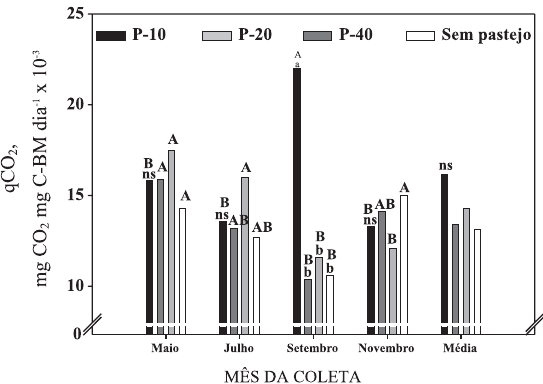
Figura 4. Quociente metabólico ( q CO ) no ciclo de 2 pastejo, na camada de 0 a 10 cm, de um Latossolo Vermelho em sistema de integração lavoura- pecuária submetido a intensidades de pastejo sob plantio direto. P-10, P-20 e P-40 representam as alturas de 10, 20 e 40 cm, respectivamente. Letras minúsculas comparam as intensidades de pastejo dentro de cada mês de coleta. Letras maiúsculas comparam cada intensidade de pastejo entre os meses de coleta. Letras semelhantes não diferem entre si pelo teste de Tukey a 5 %. ns: não